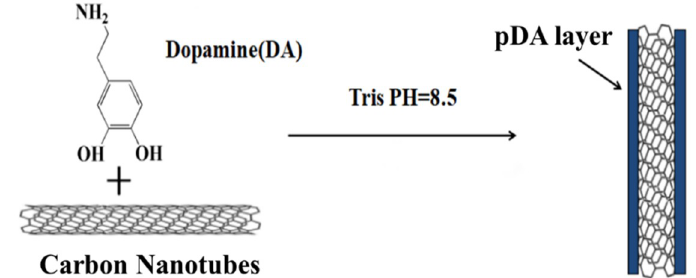
Figure 1. The schematic of the binding of dopamine to the carbon nanotubes. Under the condition of a Tris solution of pH 8.5, pDA was generated and bonded to the CNTs through the oxidative self-polymerization reaction.